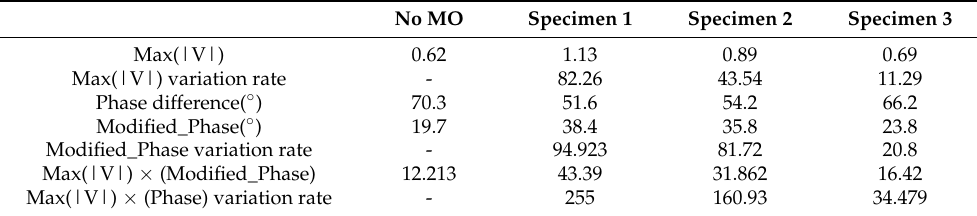
Table 2. Circuit characteristics with the presence and absence of metal object specimens in the ex- periment.